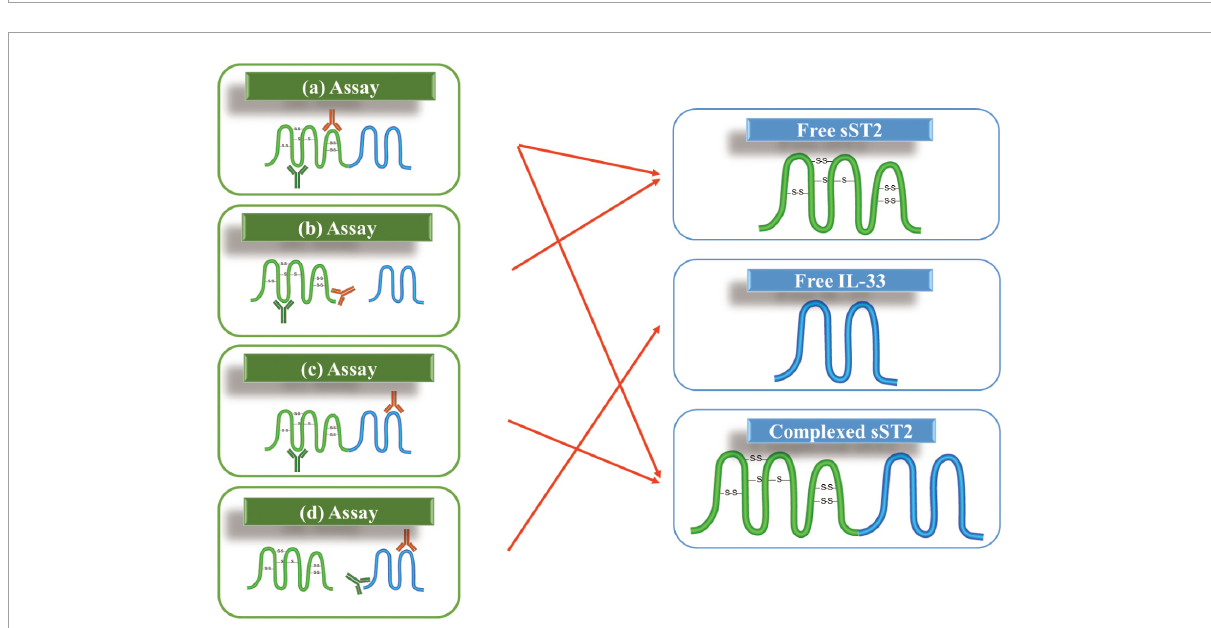
FIGURE4 Possible assay formats for measuring soluble growth stimulation expressed gene 2 (sST2) and IL-33 in the circulation: (a) two epitopes involved in sST2; (b) one antibody against an epitope on sST2 while another one against the binding site of IL-33; (c) one antibody against an epitope on sST2 while another one against an epitope on IL-33; and (d) two epitopes involved in